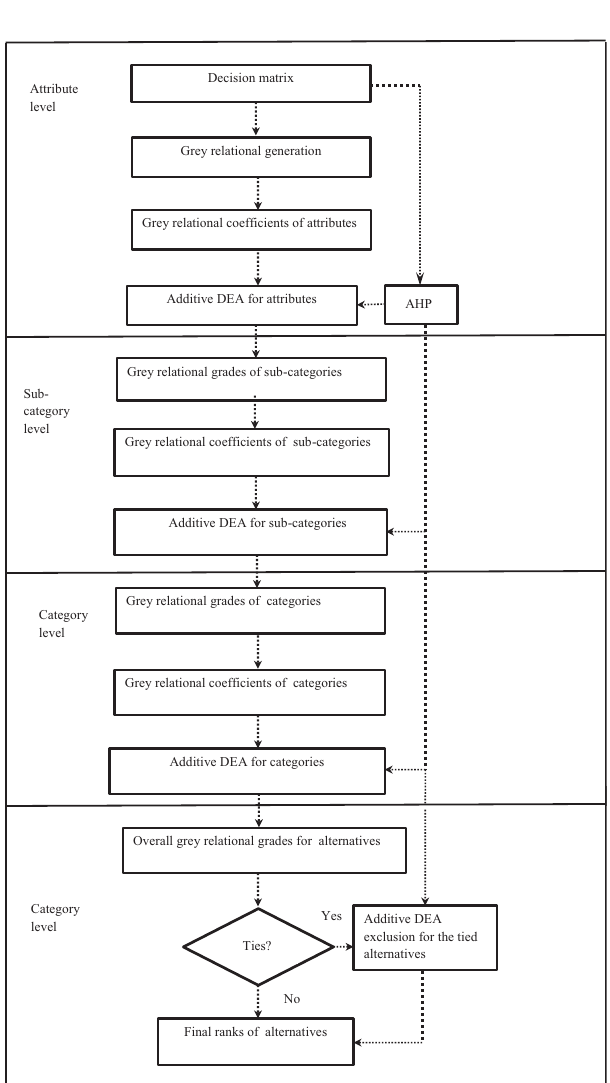
Figure A1. The fl owchart of a three-level hierarchy GRA using DEA and